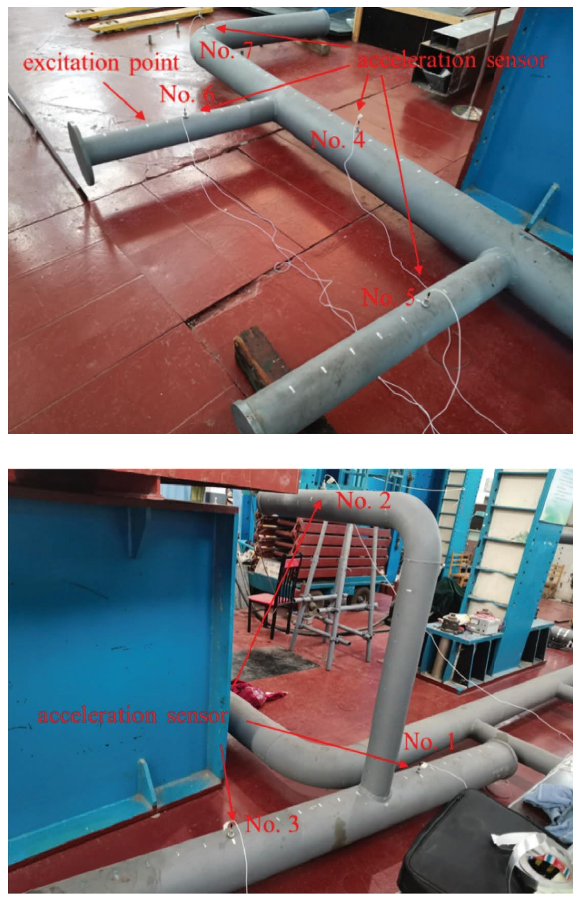
Figure 8: Layout of measuring points.